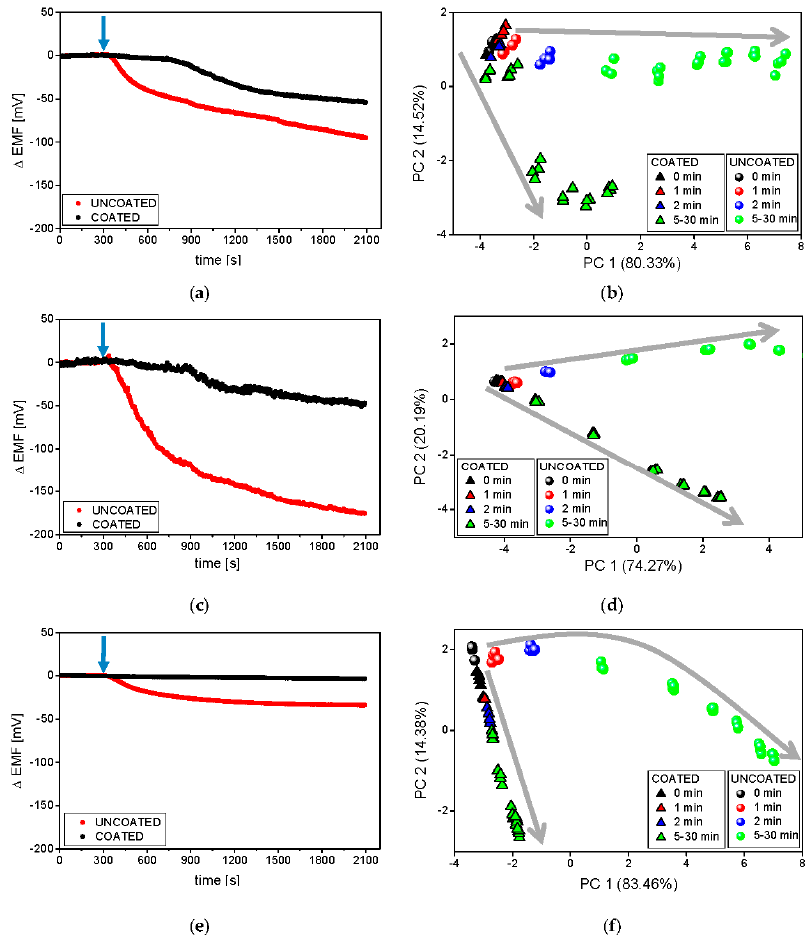
Figure 5. Raw signals of PS-N electrodes and respective PCA plots during the release process carried out at 37 °C in phosphate buffer at pH 6.9 ( a , b ), deionised water ( c , d ), and artificial saliva at pH 6.8 ( e , f ). The blue arrows represent the moment of the introduction of minitablets into the dissolution medium. Grey arrows represent following time points.